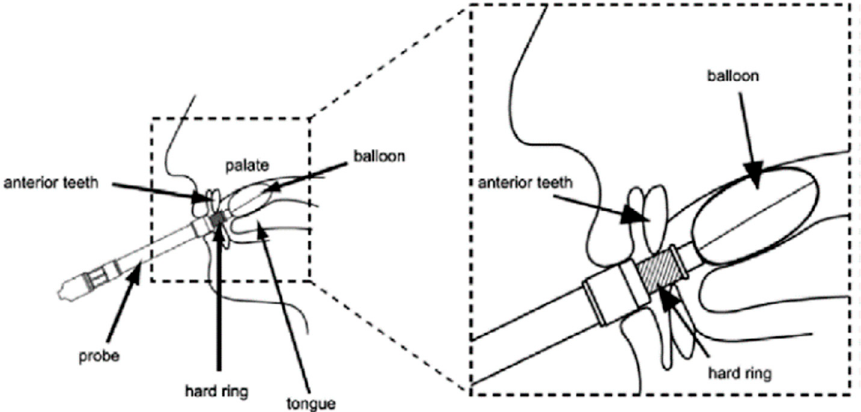
Figure 1. The method used to measure the tongue pressure [14]. The internal pressure of the balloon was adjusted to a predetermined pressure, after which it was positioned in the oral cavity as shown. The tongue pressure was measured by asking the patient to lift the tongue toward the palate with as much force as possible, as if to crush the balloon.